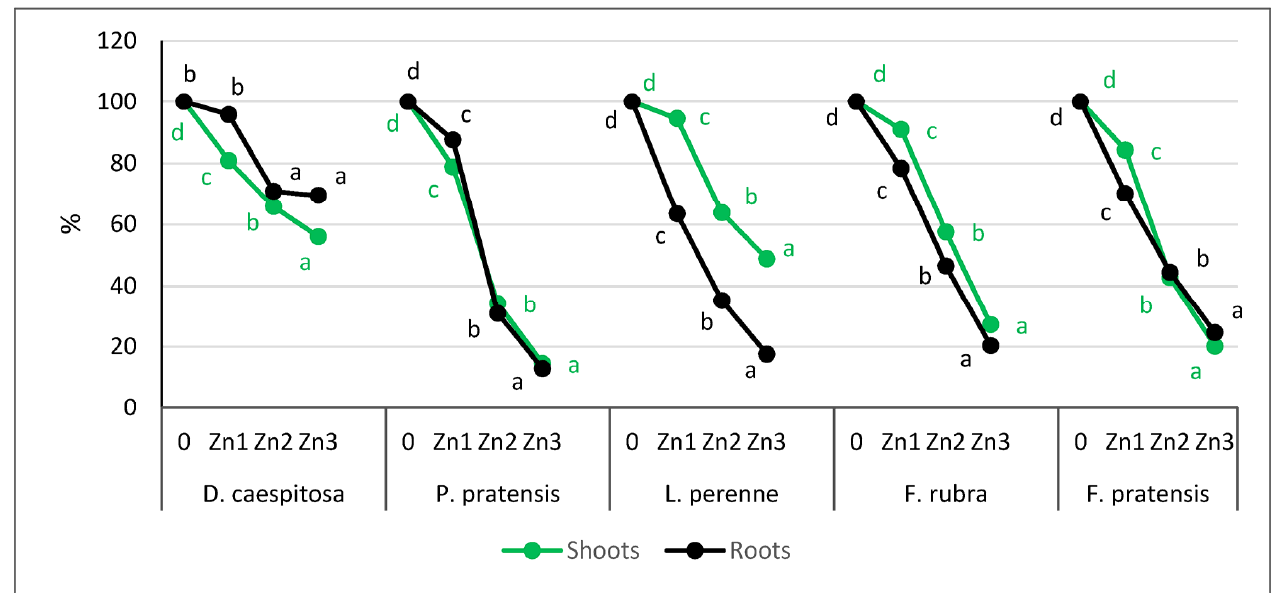
Figure 2. Relative yield (control treatment = 100%). Values marked with the same letters within one species do not differ significantly, according to Tukey’s test ( p < 0.05).